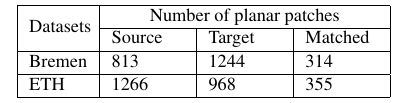
Table 2. Matched planar patches in experimental datasets